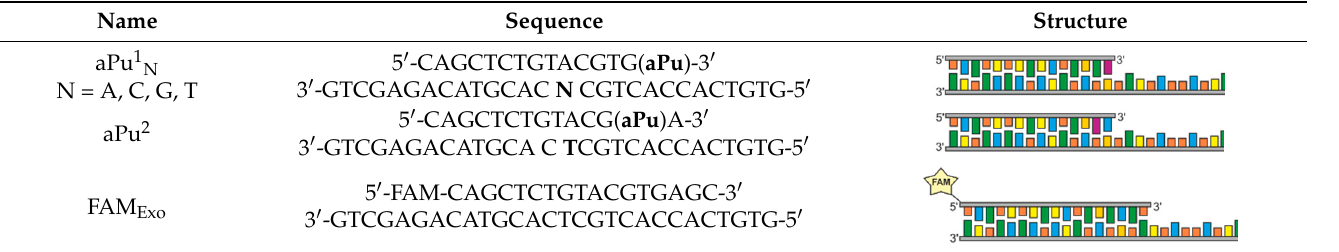
Table 3. The model DNA substrates used in this work.